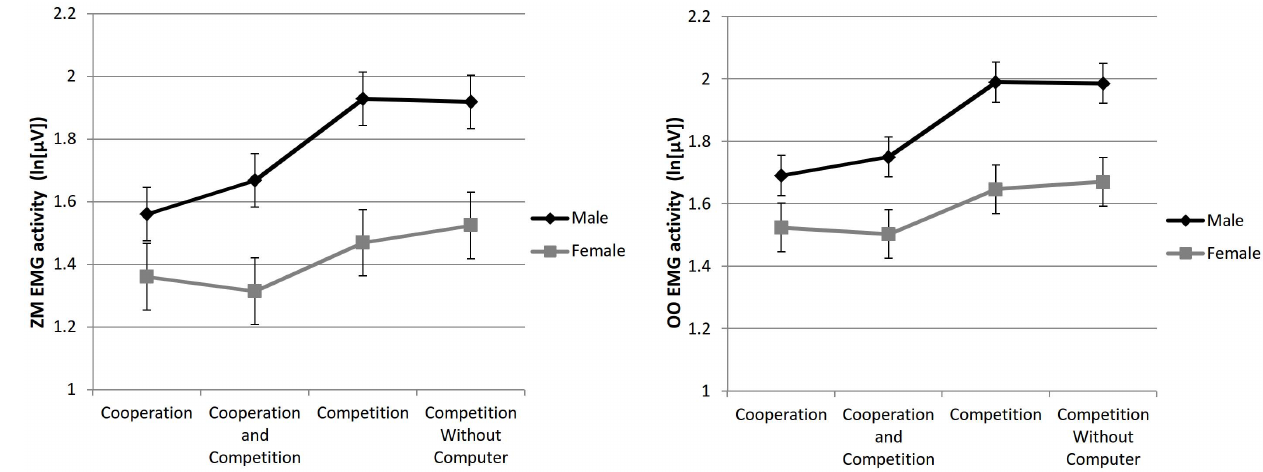
Figure 3. Gender differences in zygomaticus major (left panel) and orbicularis oculi (right panel) EMG activity, both associated with positive emotion, across the four conditions representing different modes of competitiveness (Experiment 2). The error bars represent standard errors.